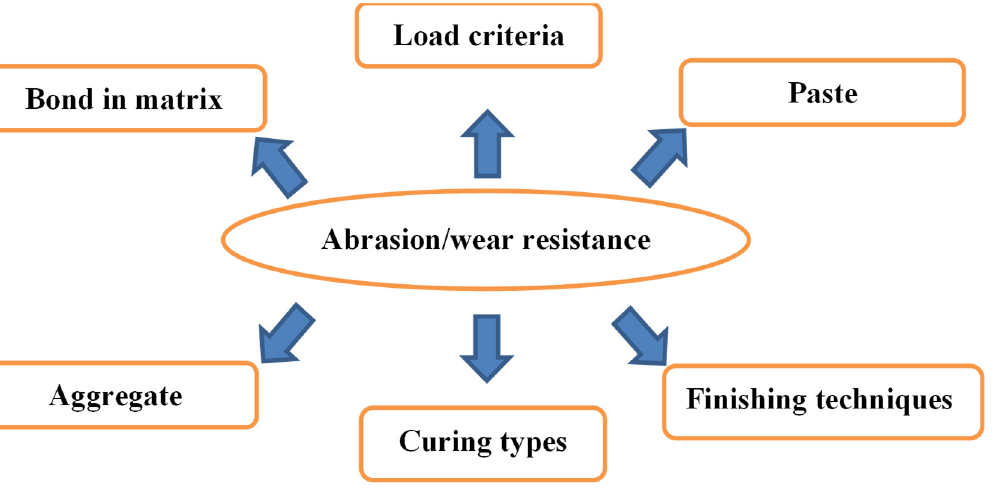
Figure 1. Parameters affecting abrasion resistance of concrete.